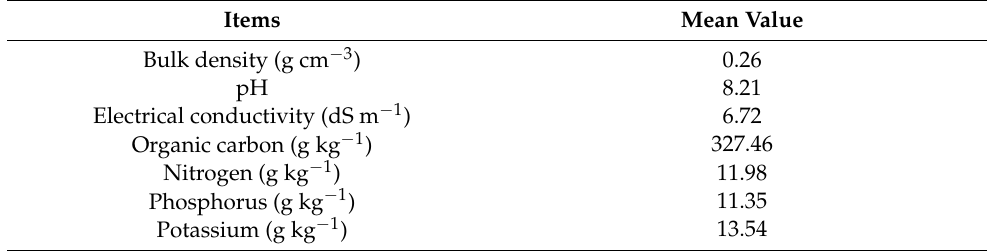
Table 2. Basic properties of cattle manure. Data were determined from mean values of 3-year